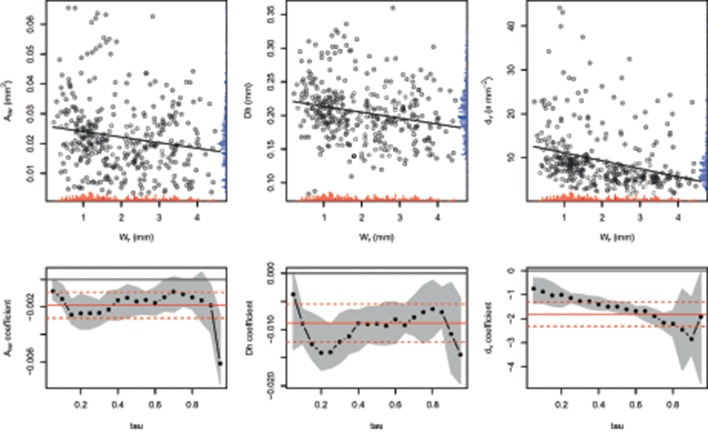
Relationships between the average vessel size [Aav; β = −0.002, F(1, 375) = 10.52, p < 0.01], hydraulic diameter [Dh; β = −0.009, F(1, 375) = 18.77, p < 0.001], vessel density [dv; β = −1.808, F(1, 375) = 34.12, p < 0.001], and tree-ring width [Wr] (upper panel). Red and blue rugs inside the plots show distribution of the x and y variables, respectively. Slope of the estimated linear quantile regression for the xylem traits as a function of the τth quantile τ (lower panels). Full red lines are the least squares estimates for the coefficients and the red dashed lines are the 95% confidence intervals for the least squares estimates. The gray area represents the 95% confidence interval (1000 replicate bootstrap) for the quantile regression estimates (full circles, each 5th quantile).